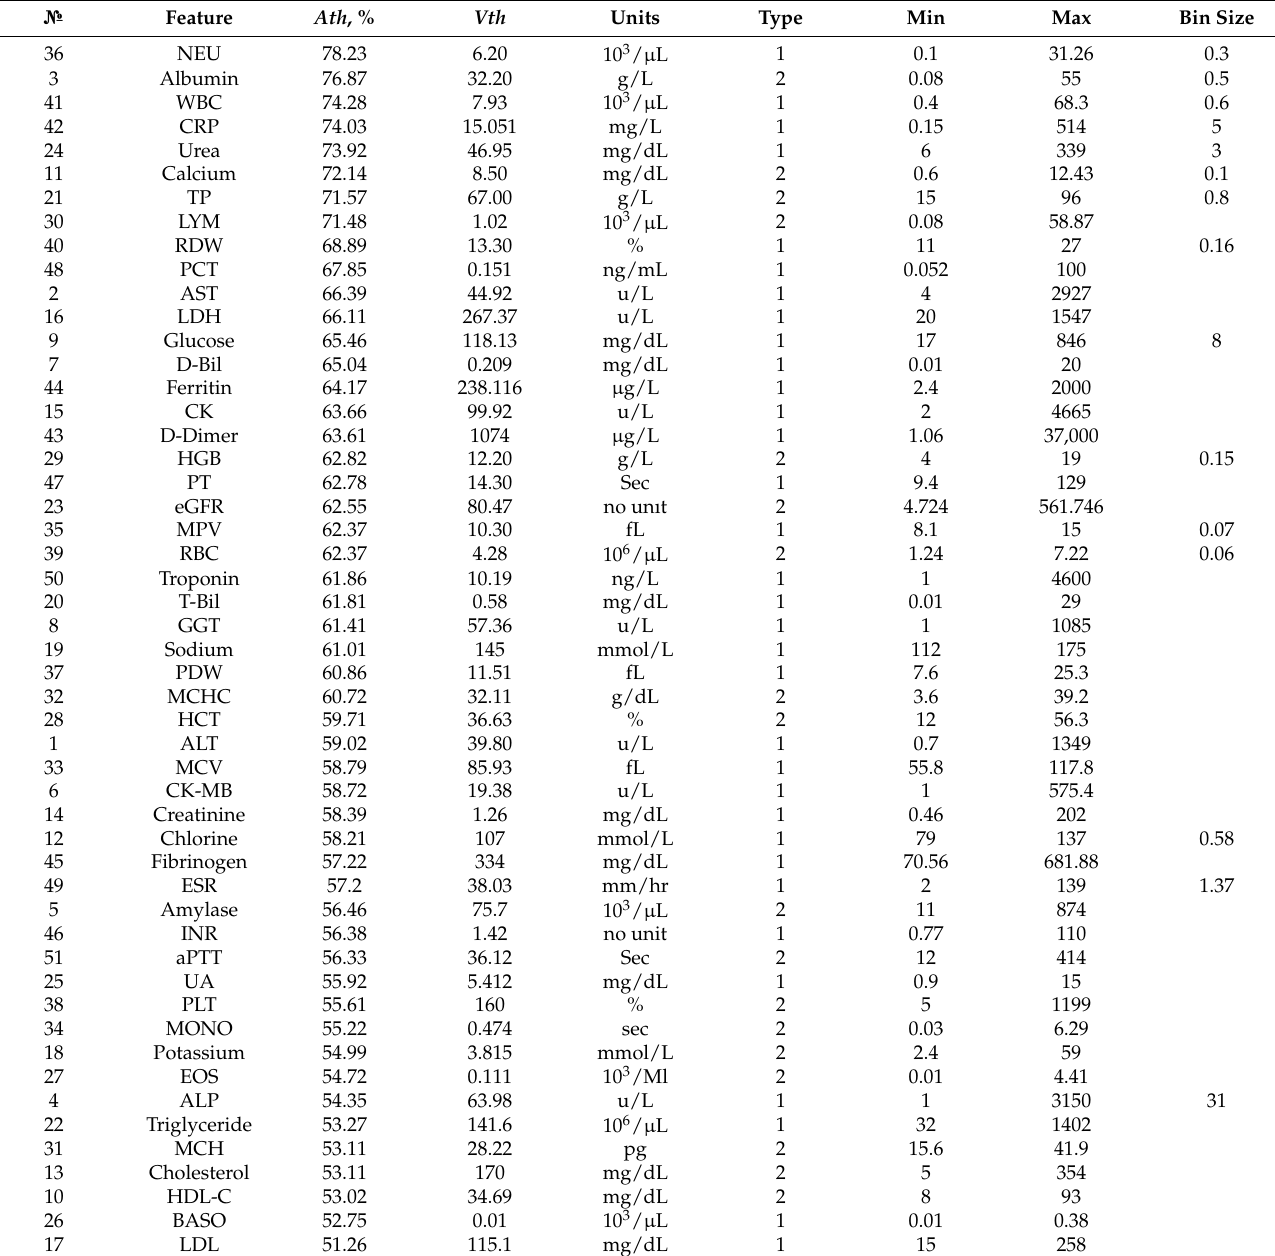
Table A2. Threshold method parameters for SARS-CoV-2-RBV2 dataset and histogram bin sizes for Figures 9 and